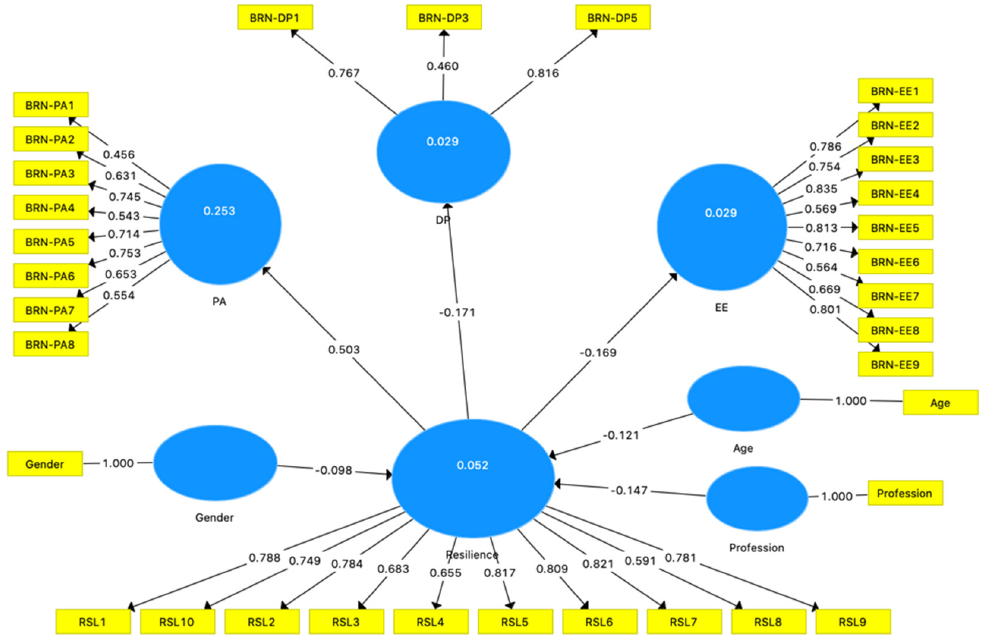
Figure 1. PLS-SEM Path Model. Note: DP: Depersonalization; EE: Emotional Exhaustion; PA: Personal Accomplishment.